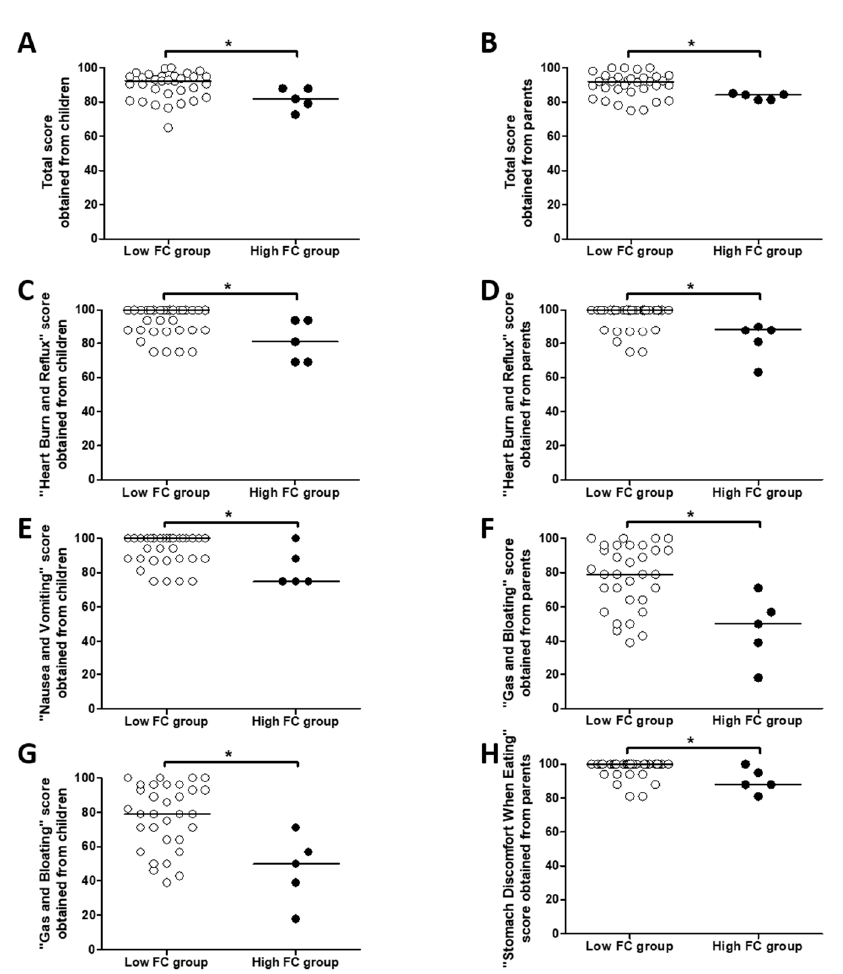
Figure 1. Di ff erences in Gastrointestinal Symptoms Scales 3.0-PedsQL TM scores according Fecal calprotectin (FC) level. Di ff erences between the Gastrointestinal (GI) Total score ( A , B ), the “Heart Burn and Reflux” score ( C , D ), the “Nausea and Vomiting” score ( E , F ), the “Gas and Bloating” score ( G ) and the “Stomach Discomfort When Eating” score according to the presence (High FC group) or not (Low FC group) of fecal calprotectin level > 250 µ g / g of stool. Comparisons were performed between scores obtained from children ( A , C , E , G ) or by their parents ( B , D , F , H ) with Mann–Whitney tests. * p <